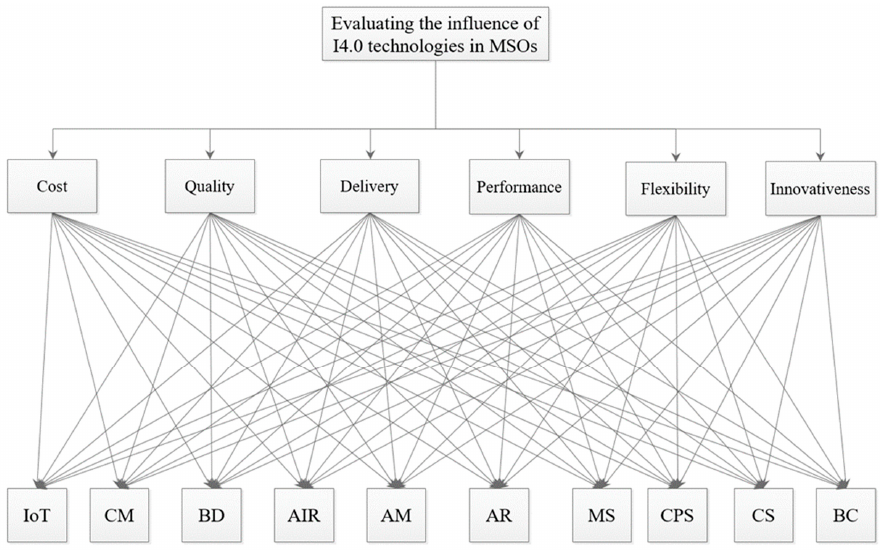
Figure 3. I4.0 technologies on MSOs evaluation network.